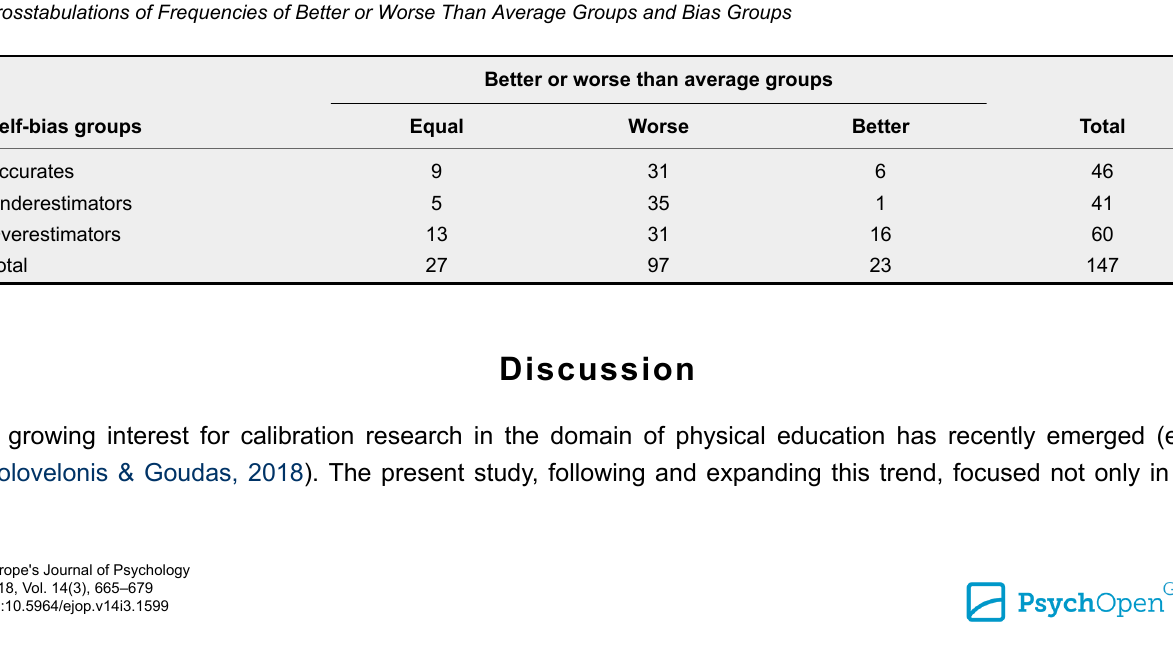
Crosstabulations of Frequencies of Better or Worse Than Average Groups and Bias Groups Self-bias groups Accurates